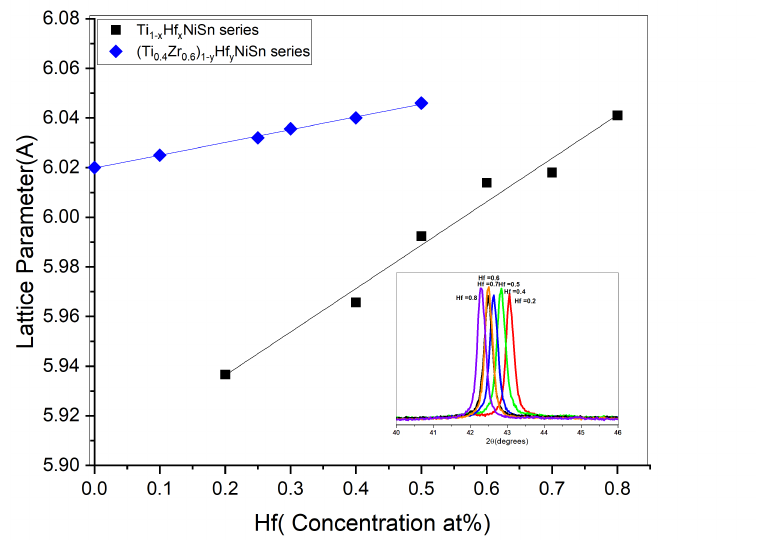
Figure 4. Increase of unit cell for the Ti 1 − x Hf x NiSn samples and the (Ti 0.4 Zr 0.6 ) 1 − y Hf y NiSn samples. Backscattered SEM images and EDS results confirmed that the pellets were single phase and according to the nominal composition (see Figure 5 and Tables 1 and 2). These results are in contrast with arc melting synthesis of similar compositions, where impurity phases like Ti 6 Sn 5 , ZrSn 2 and Ni 3 Sn 4 were included in the final pellets [31]. A. Page et al. calculated the (Hf, Zr,Ti)NiSn thermodynamic phase diagram and suggested the coexistence of Ti-rich and Ti-poor grains for arc melted samples, as non-equilibrium states created during solidification and kinetically trapped at lower temperatures [32]. The solid solubility limit of these diverse systems depends on the synthesis technique; thus, the mechanism of solid solutions in MA is different compared to arc melting. Along with that, the solid solutions are formed in full composition range in the Cu-Fe, AlSb-InSb, and Cu-Co systems via MA, but this is not in case for arc melting, which is a rapid solidification process (RSP) [33].